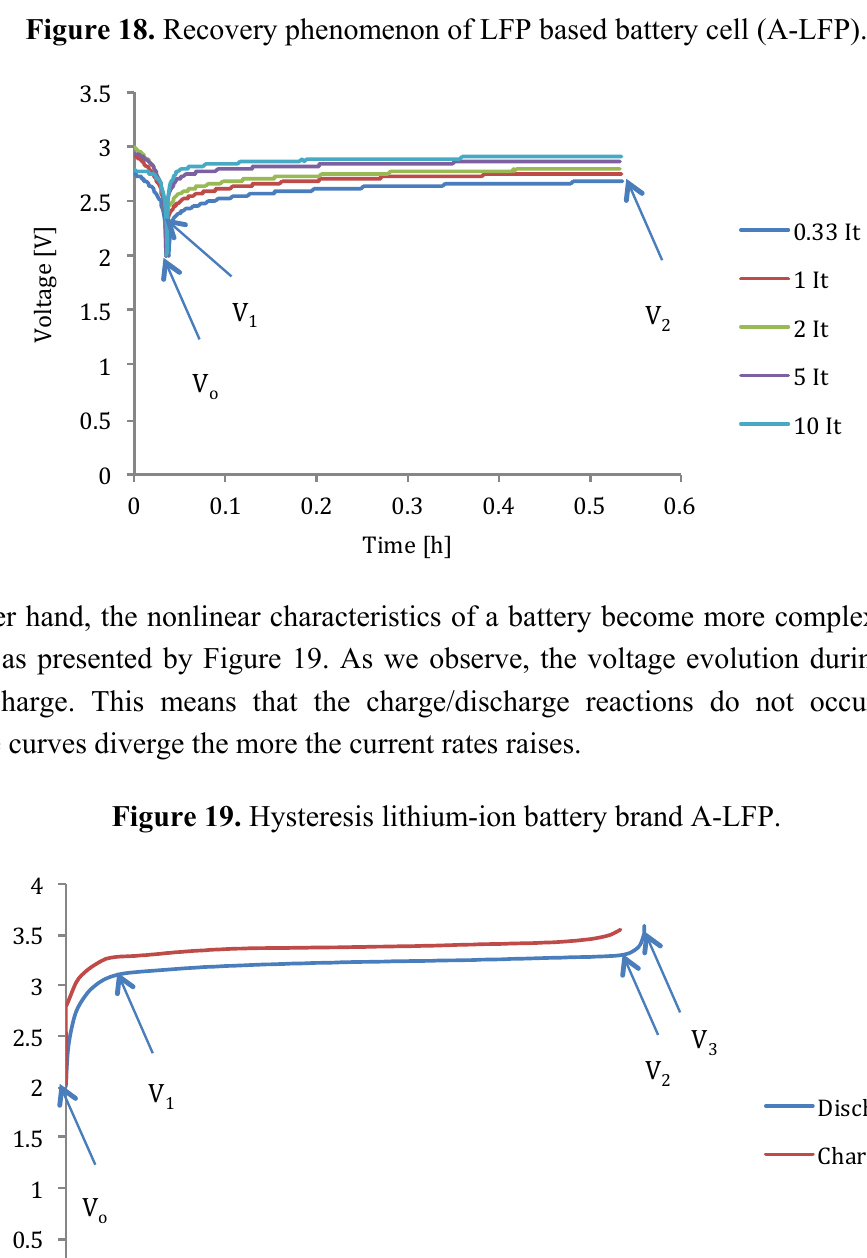
Figure 18. Recovery phenomenon of LFP based battery cell (A-LFP).